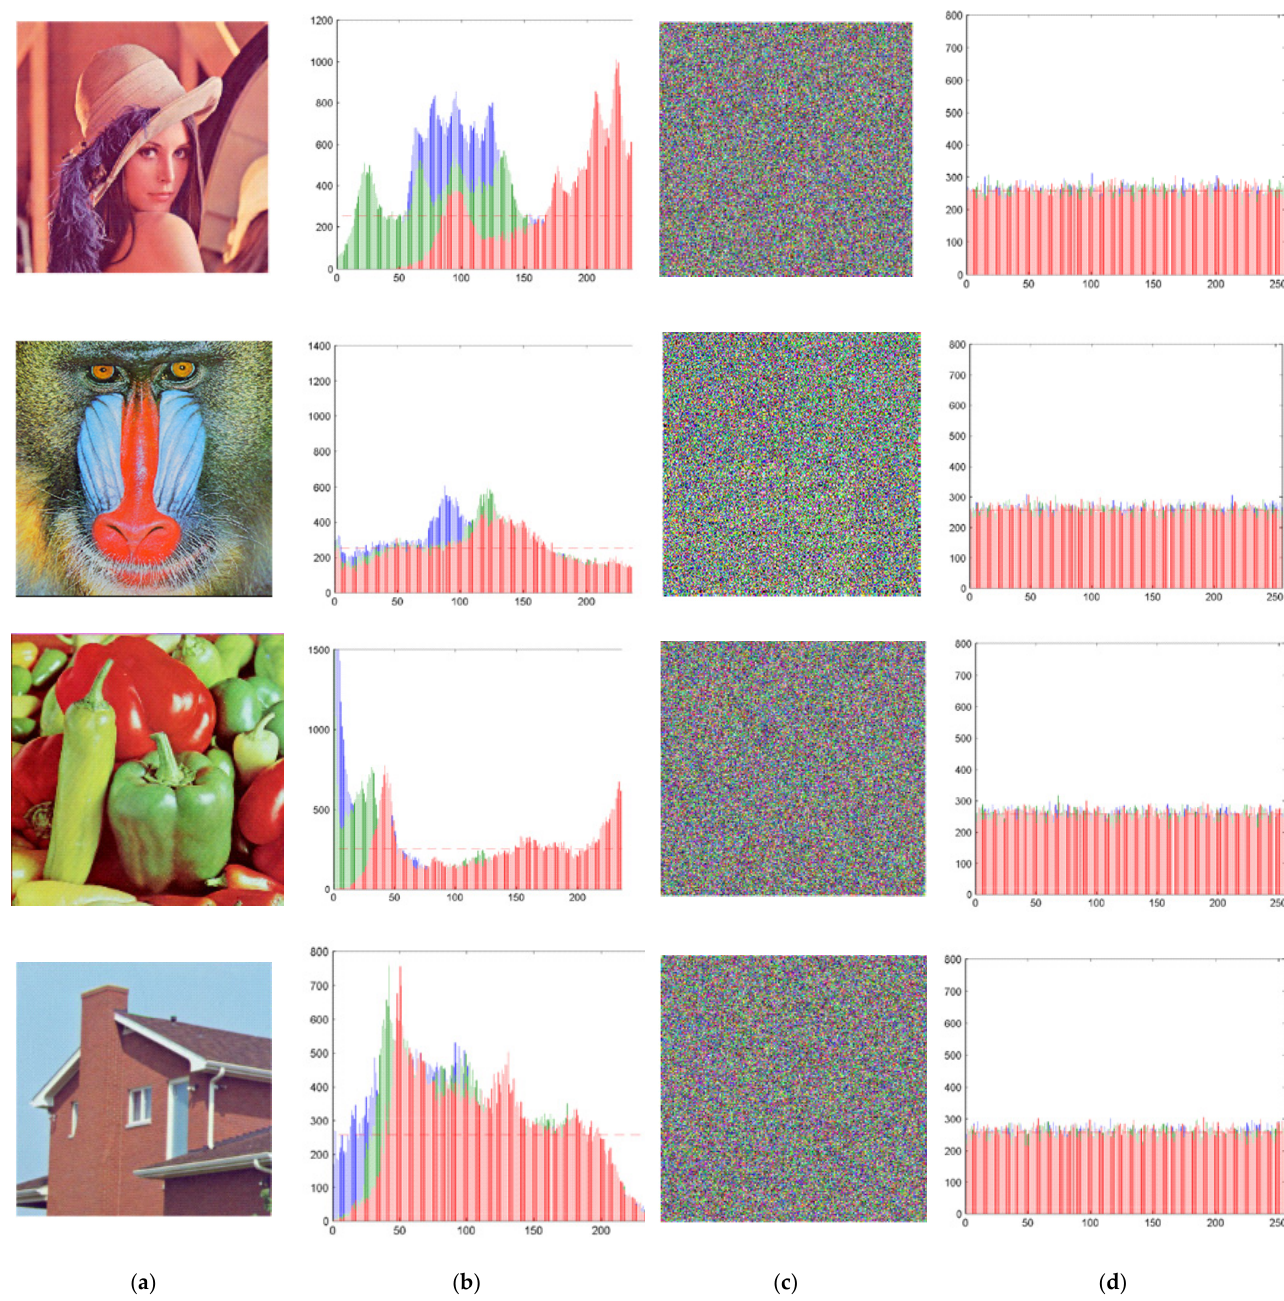
Figure 5. Histograms of colored plain images. ( a ) Plain images. ( b ) Histograms of plain images. ( c ) Cipher images. ( d ) Histograms of cipher